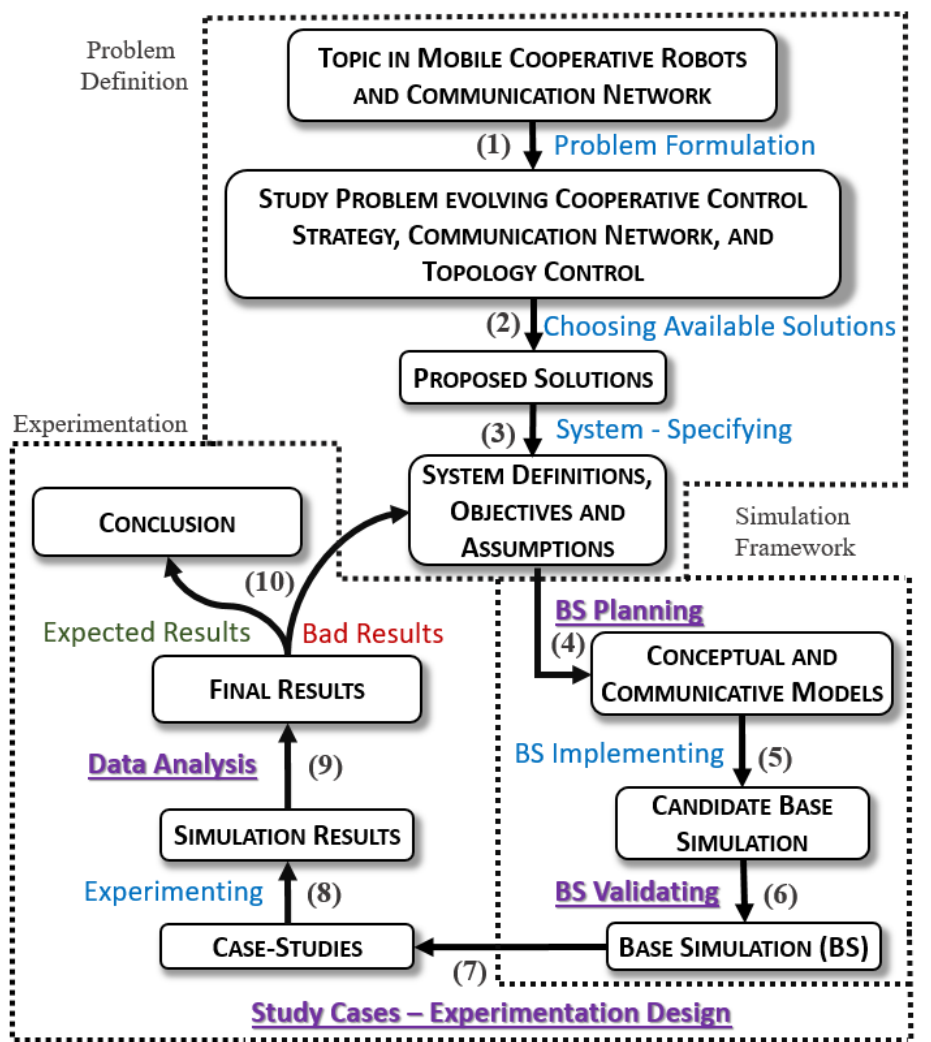
Figure 1. The Integrated Robotics and Network Simulation (IRoNS) method to build integrated robotics and network simulation studies, represented in terms of actions (arrows) and results (boxes). The underlined actions indicate critical points detailed in this paper.